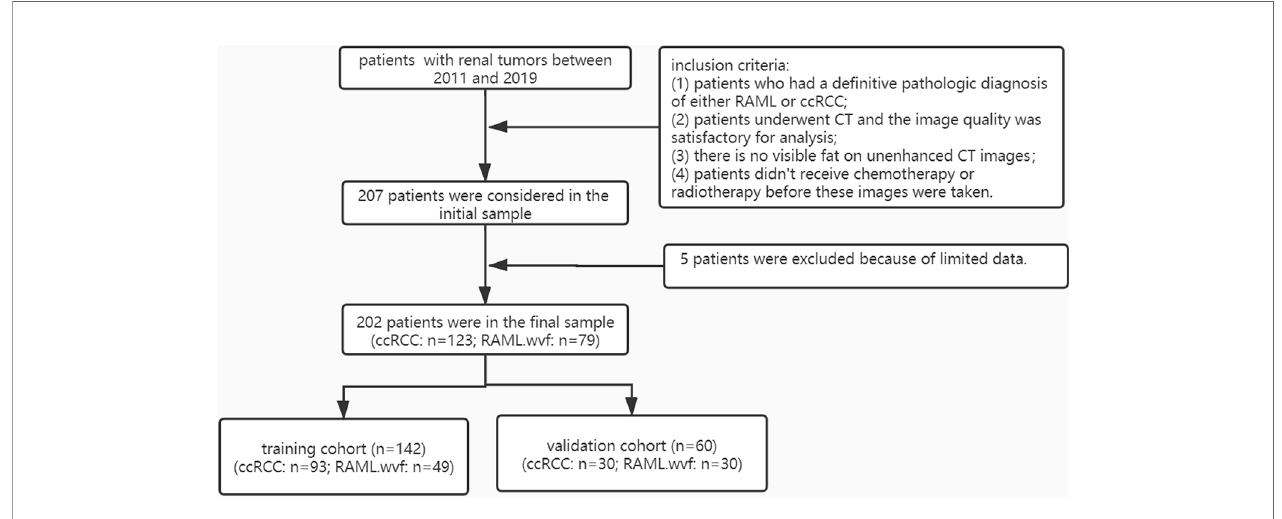
FIGURE 1 | Patient fl ow